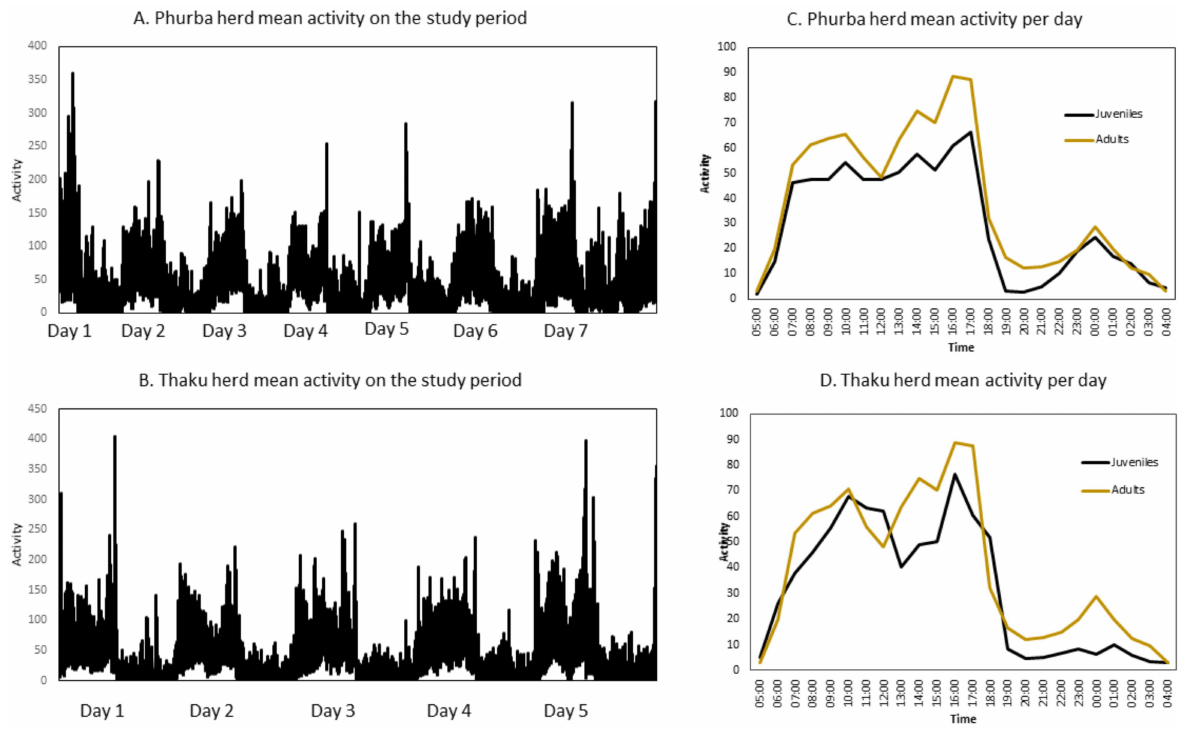
Figure 2. Activity rate of herd yaks measured using Actigraph. Spatial cohesion : The mean number of subgroups observed using GPS was 1.22 ±